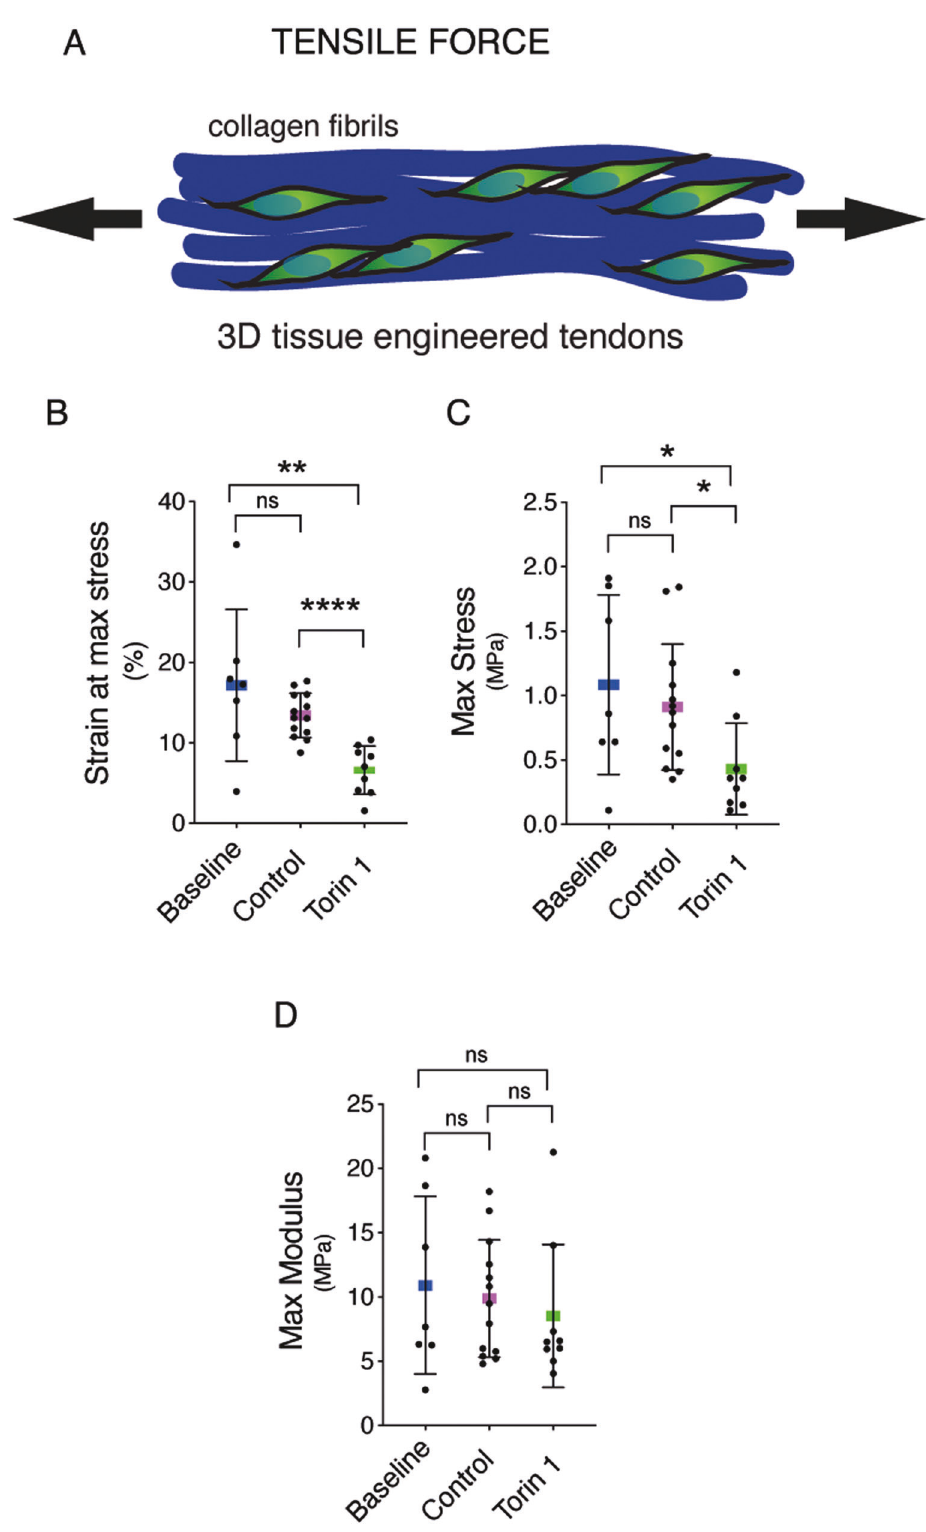
Fig. 8 Pharmacological inhibition of mTOR by Torin 1 affects matrix quality. A Graphical representation of the tensile force applied to the tissue-engineered tendons. Maximum stress ( B ), strain at maximum stress ( C ), and maximum modulus ( D ). n = 3 tissue donors, with a minimum of 7 tissue-engineered tendons per cell preparation for each treatment for each parameter measured, * p < 0.05, ** p < 0.01, **** p < 0.0001, unpaired t -test.